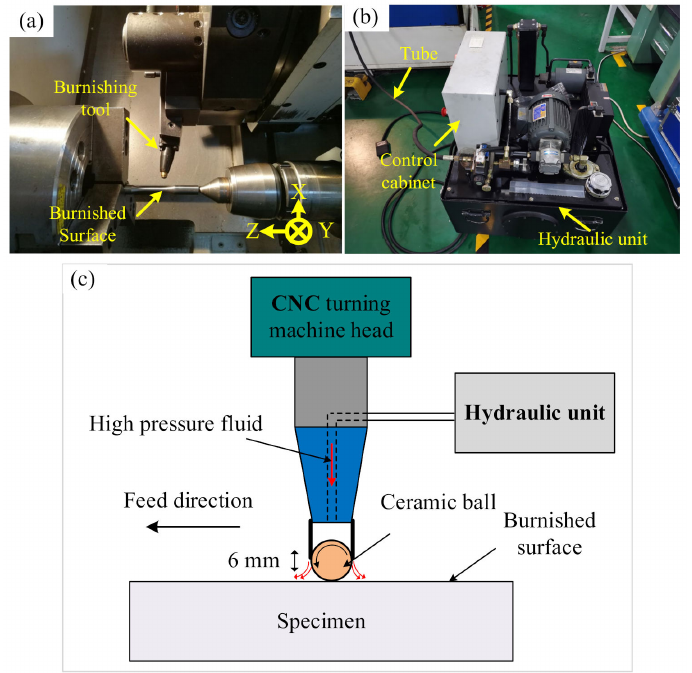
Figure 3. LPB experimental set-up: ( a ) LPB process on the CNC turning center; ( b ) hydraulic unit; ( c ) principle of LPB process.